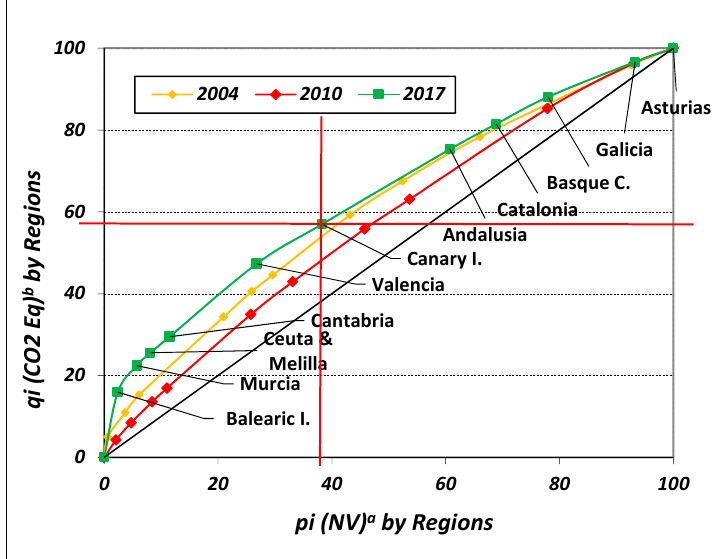
Figure 8. Lorenz curves of emissions of CO 2 equivalent of the tugboats in Spanish ports by region. Source: authors. a = % accumulated number of tugboats by regions; b = % accumulated emissions of CO 2 equivalent by region.